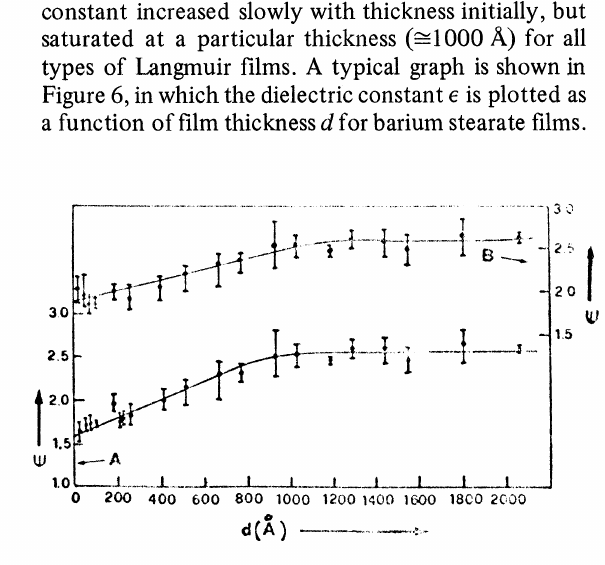
FIGURE 6 Dielectric constant e vs. film thickness d of barium stearate film. (A) without oxide layer effect, (B) with oxide layer effect. [After Khanna